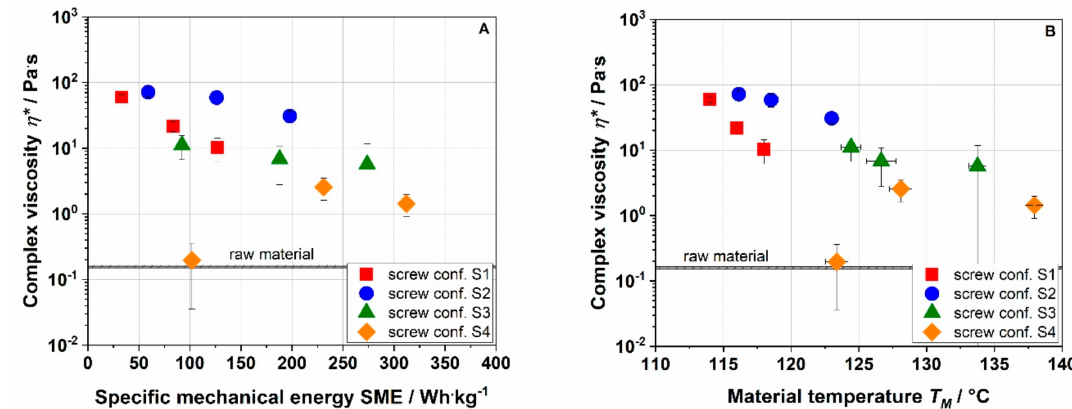
Figure 10. Effect of specific mechanical energy SME ( A ) and material temperature T M ( B ) on complex viscosity ( η *) of apple pomace for various screw configurations at water content of 22%. S1: only transport elements, S2: two reverse elements, S3: four reverse elements, S4: two reverse elements and a kneading